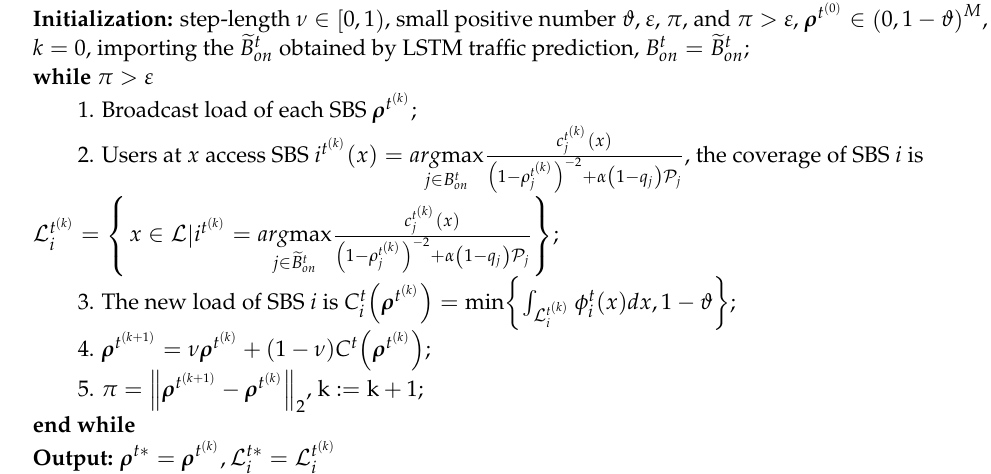
Algorithm 1. Enabling the optimal user association algorithm for the case of base station set